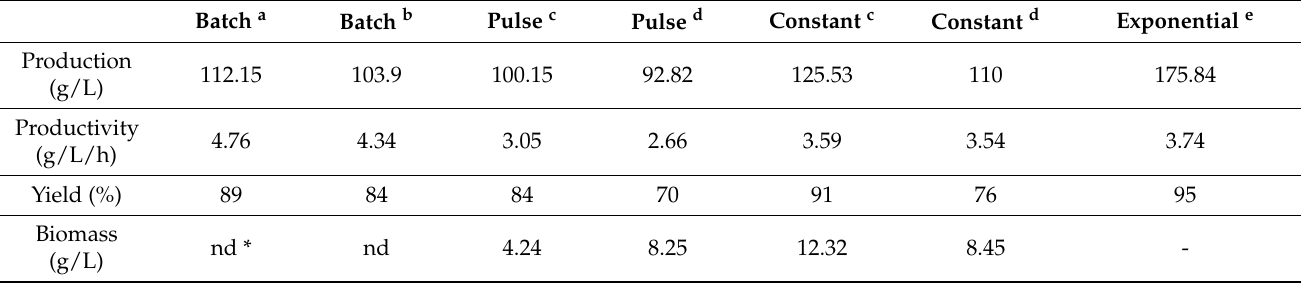
Table 7. Highest values obtained among batch in shaker, batch in reactor and fed batch in